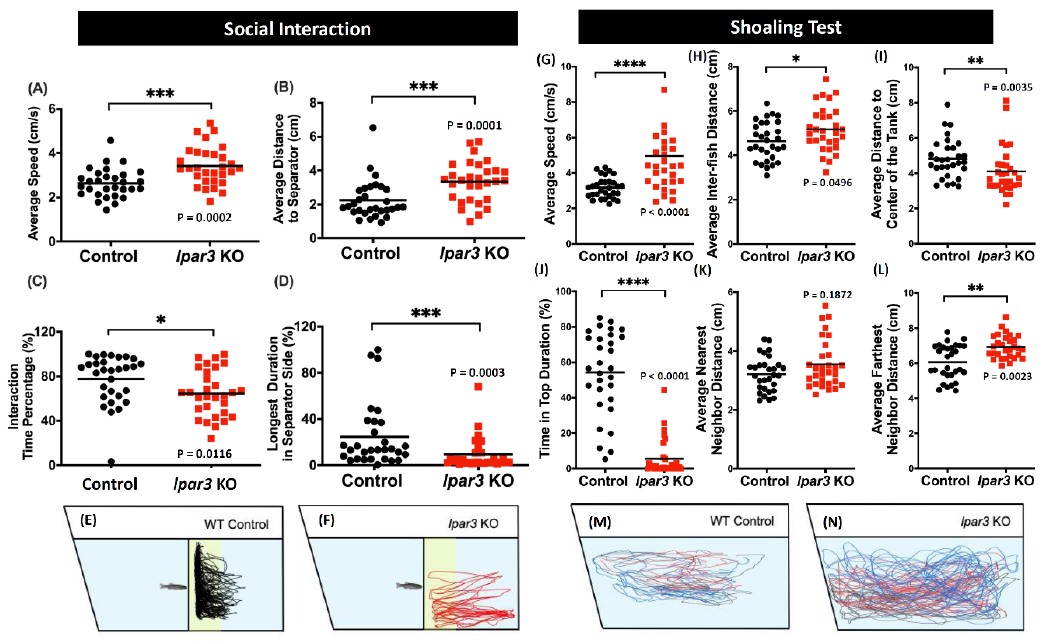
Figure 4. Comparison of behavior endpoints between wild-type (black) and lpar3 KO (red) fish in social interaction ( A – F ) and shoaling ( G – N ) tests. In the social interaction test, average speed ( A ), average distance in separator side ( B ), interaction time percentage ( C ), and longest duration in separator side ( D ) were analyzed. Locomotor trajectories of wild-type ( E ) and lpar3 KO fish ( F ) for social interaction assay were plotted to facilitate visualization. ( G ) Average speed, ( H ) average inter-fish distance, ( I ) average distance to the center of the tank, ( J ) time-in-top duration, ( K ) average nearest neighbor distance, and ( L ) average farthest neighbor distance were analyzed during the shoaling test. Locomotor trajectories of wild-type ( M ) and ( N ) lpar3 KO fish for the shoaling test were plotted to facilitate visualization. The data are expressed as the median and were analyzed by nonparametric Mann–Whitney test ( n = 30 for both groups; * p < 0.05, ** p < 0.01, *** p < 0.001, **** p <